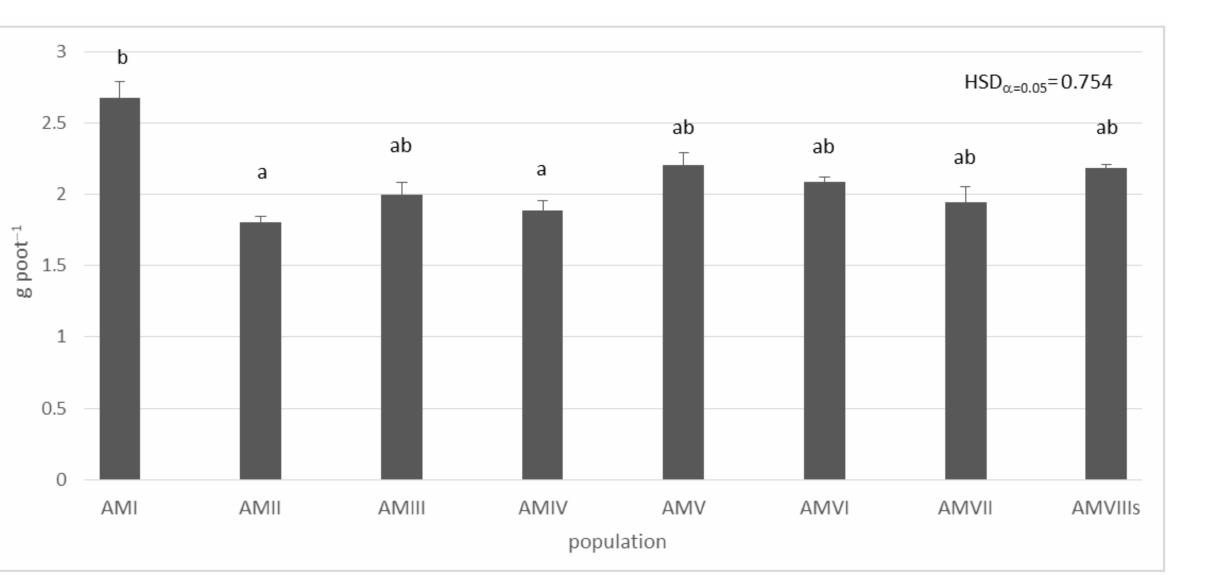
Figure 1. Shoot fresh weight of A. myosuroides plants without herbicide treatment. Means labeled with the same letter do not differ significantly. The statistical analysis of the significance of differences was performed using the Tukey test for each population separately. Data are means ± SE, n = 3. Means marked by the same letter do not differ